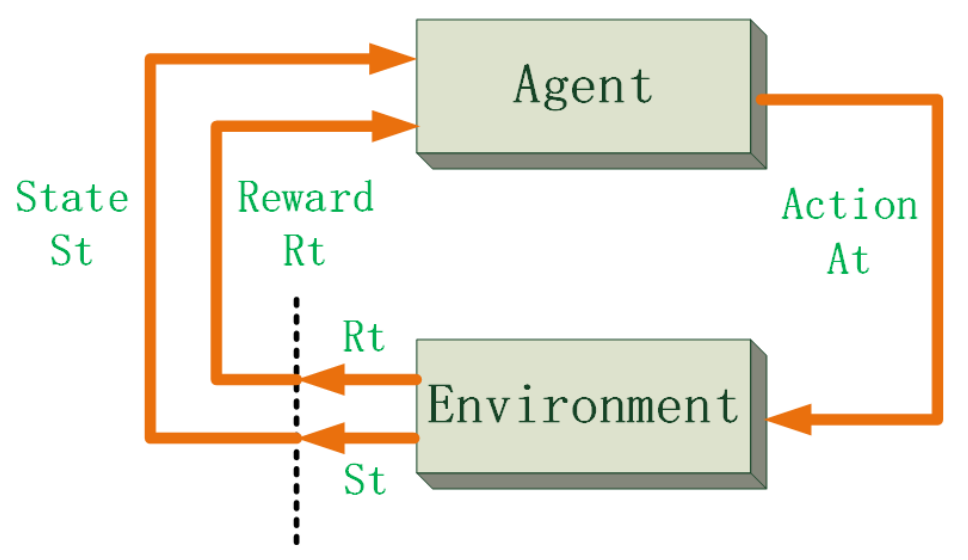
Figure 6. Markov decision process.